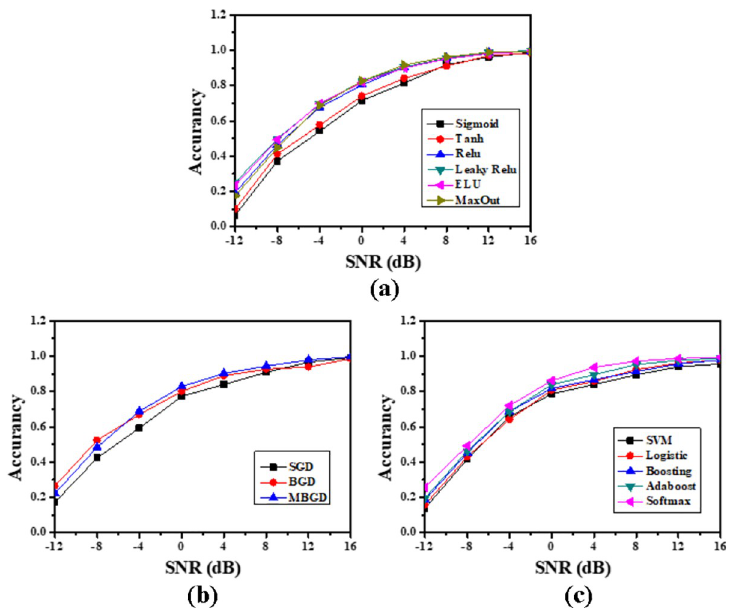
Fig 5. Influence of different parameter settings on the accuracy of model